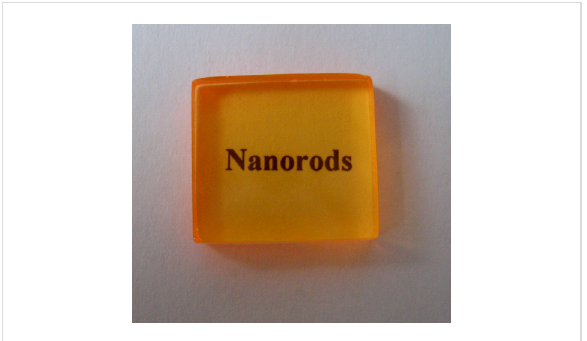
Figure 8: Photograph showing the high transparency of a 5 mm thick 0.05 wt % NR/P(LMA- co -EGDM) composite.